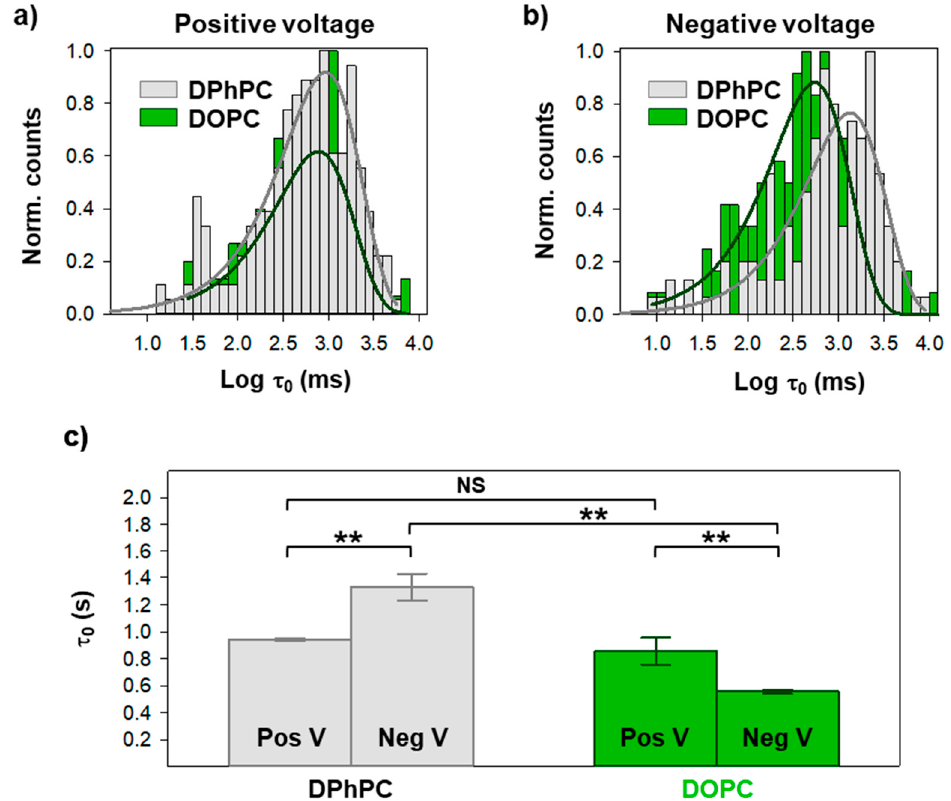
Figure 4. Change in acyl chain composition modulates closure of first OmpF monomer. Logarithmically binned histograms of the time the channel spends in the open conformation under a positive ( a ) or a negative ( b ) applied voltage when inserted in membranes composed of pure DPhPC or DPhPC/DOPC (diphytanoyl-phosphatidylcholine/dioleoyl-phosphatidylcholine 1/1, labelled as DOPC), as indicated. Solid lines are exponential fittings. The characteristic times obtained from exponential fittings are shown in ( c ). See Figure S1 for the distributions in ( a ) and ( b ) displayed individually. In ( c ), significance between mean closure times was determined with a one-way ANOVA significance test. A Holm-Sidak post hoc test was used for pair-wise comparison (NS (not significant): p > 0.2; **: p < 0.01). See Materials and Methods for more details.